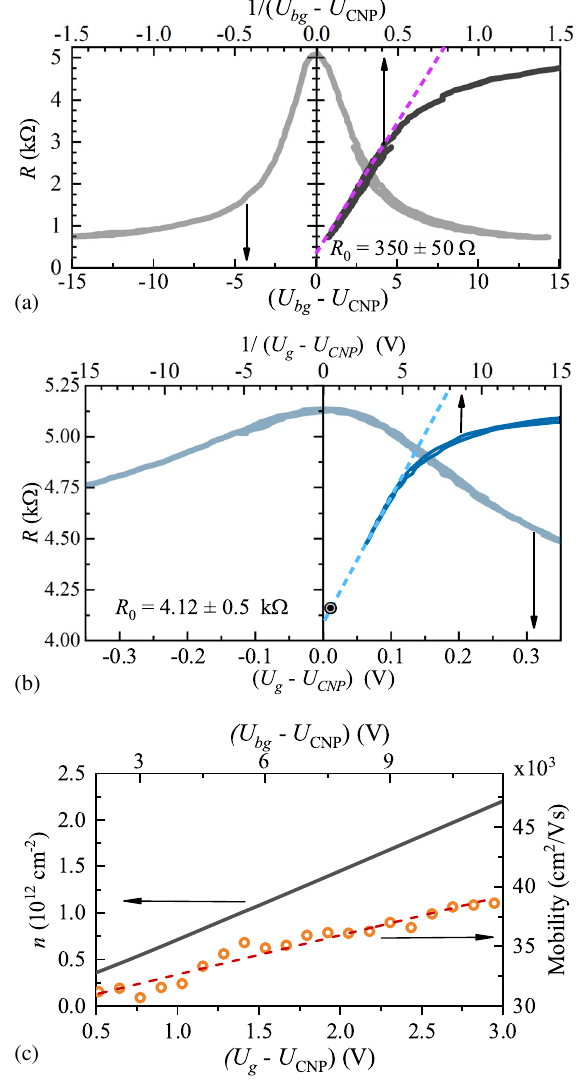
FIG. 2. Electrical characterization of the samples. Ambipolar resistance versus back gate (a) and top gate for the C 1 cavity (b) of the A-DGG3.1 structure. We also show resistance versus − U (cid:2) that allows extraction of inverse swing voltage ½ 1 = ð U g CNP the resistance of the contacts (a) and the resistance of total ungated part of samples for the C 1 cavity (b). C 1 cavity carrier density n and mobility as a function of the gate voltage (c): The lower horizontal axis corresponds to the top-gate bias, and the upper horizontal axis is for the back-gate